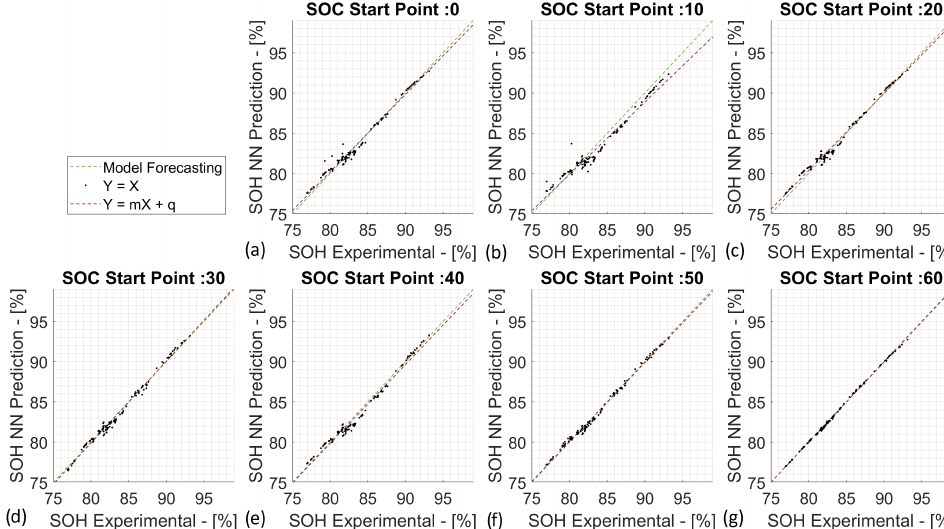
Figure 12. Best neural network regression performance. ( a ) refers to the SOC window [0,40], ( b ) refers to the SOC window [10,50], ( c ) refers to the SOC window [20,60], ( d ) refers to the SOC window [30,70], ( e ) refers to the SOC window [40,80], ( f ) refers to the SOC window [50,90], ( g ) refers to the SOC window [60,100]. The black points represents the correlation points between predicted and target values. The green dashed line is the bisector, and the red dashed line is the fitting regression line. The regression parameters can be observed in Table 5. The predicted SOH points over the entire cycle aging test are those of test set for perfomance